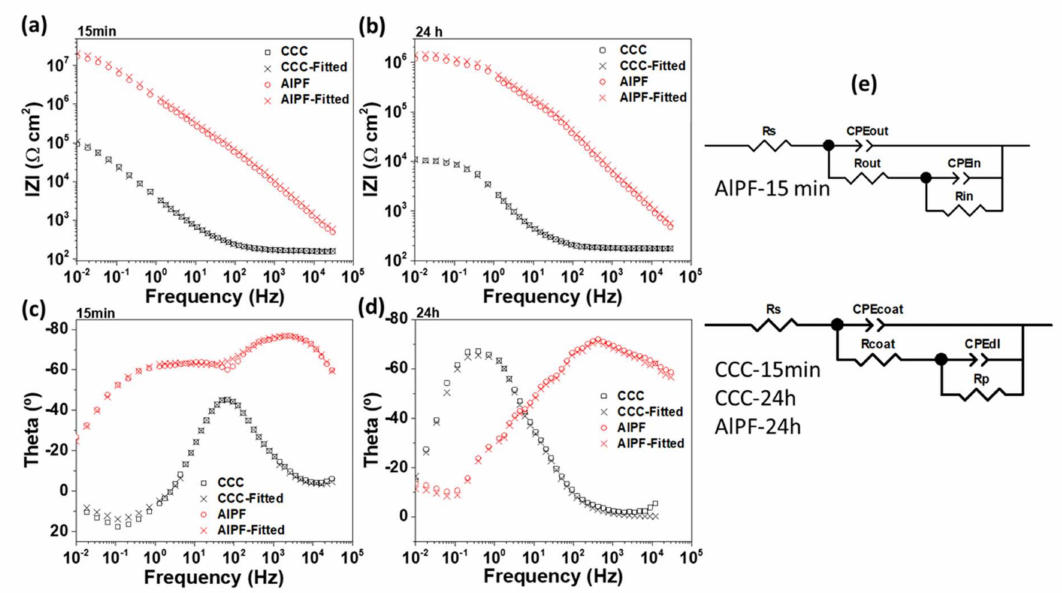
Figure 8. Bode plots (empty symbols) for AlPF coating and CCC after ( a , c ) 15 min and ( b , d ) 24 h immersion in 0.5% NaCl with fittings (cross symbols) simulated with equivalent circuits ( e ).